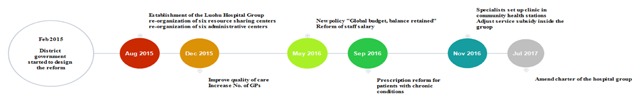
Timeline of the Luohu reform.